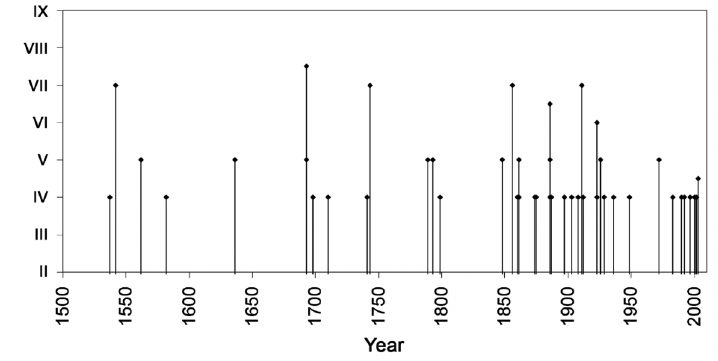
Fig. 4. Site seismic history for the Maltese islands since 1500, showing EMS-98 I ≥